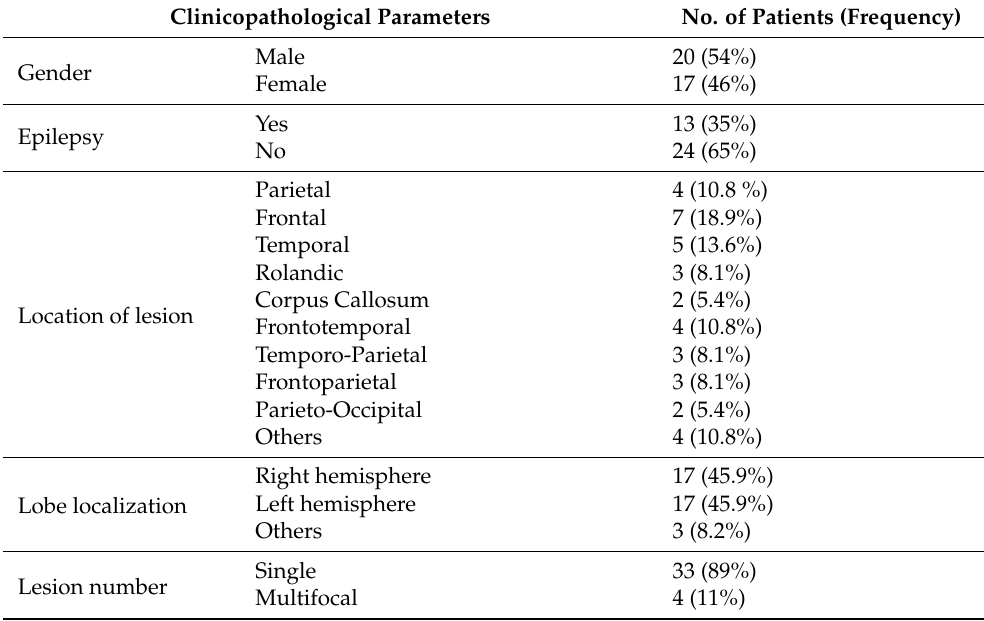
Table 1. Demographic data, tumor characteristics, and treatments strategies of 37 GBM patients enrolled in this